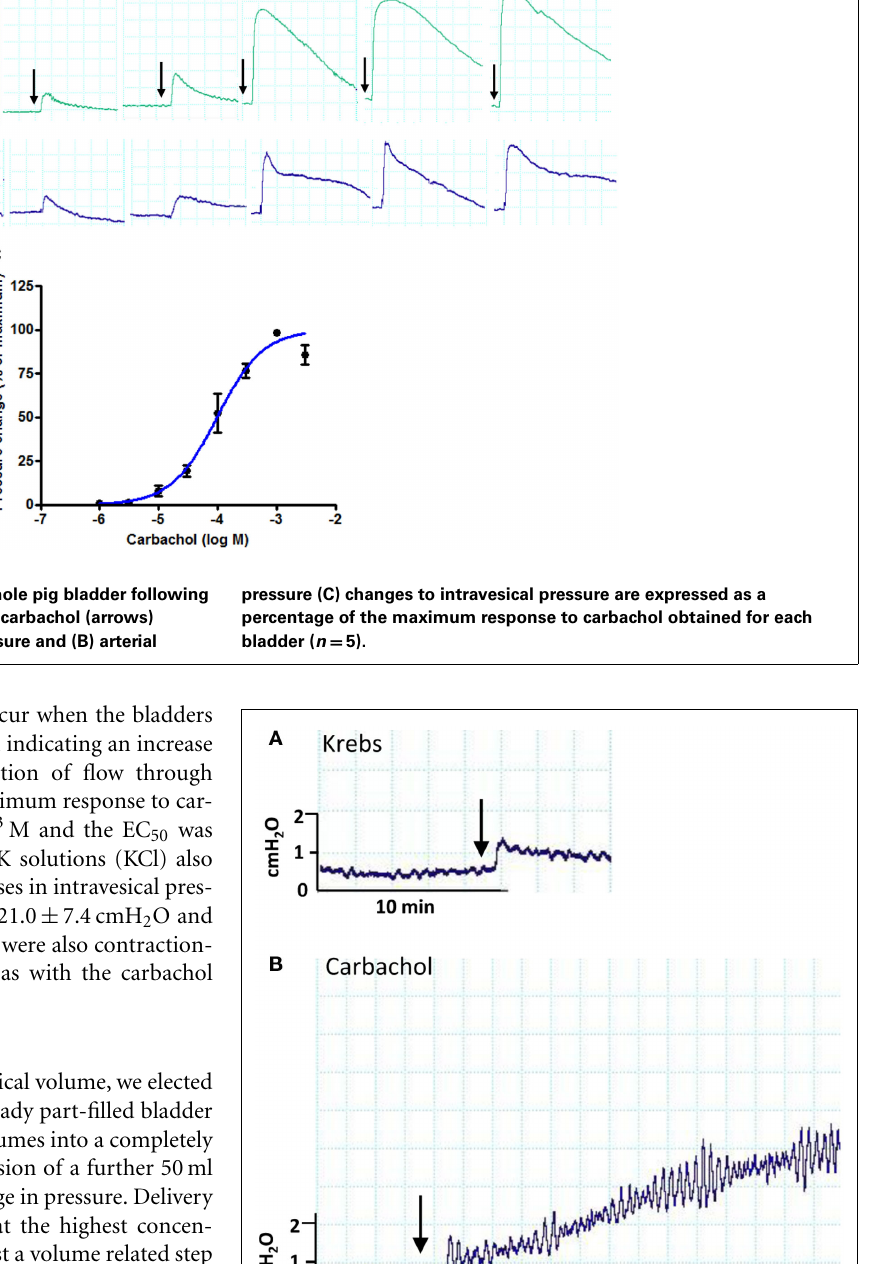
FIGURE 3 | Pressure traces derived from an isolated whole pig bladder following administration of: (A) intravesical Krebs’ solution and (B) Krebs’ solution containing 3 × 10 − 3 M